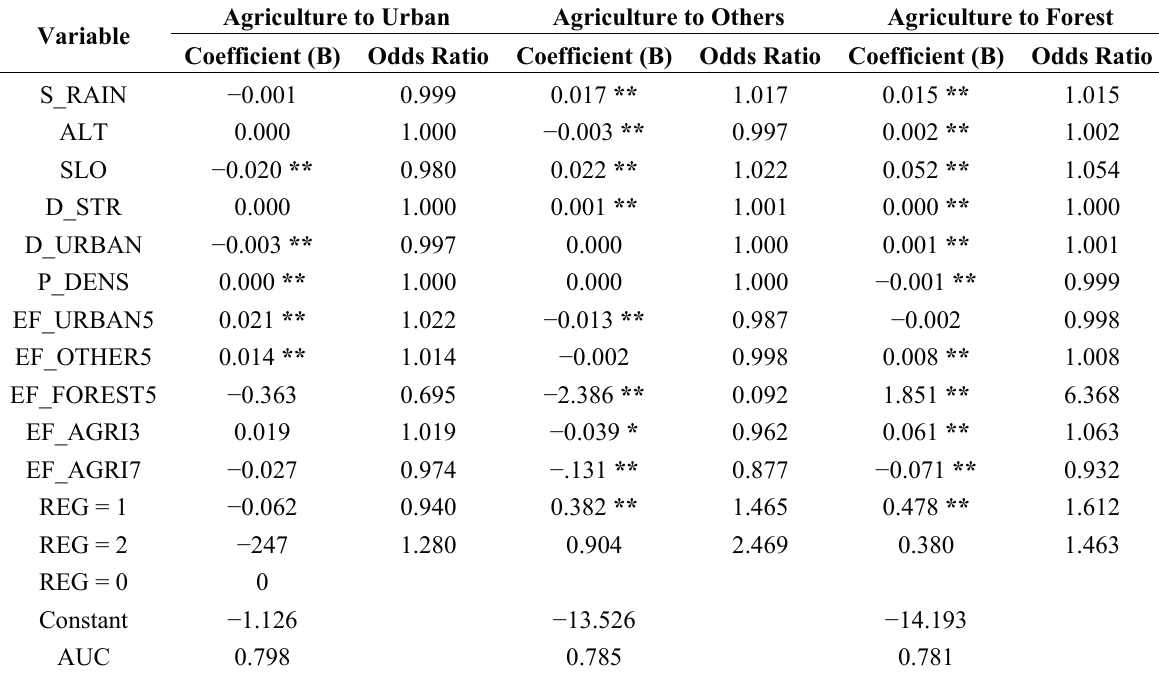
Table 8. Factors of agricultural land-use changes using logistic regression (1990~2000).